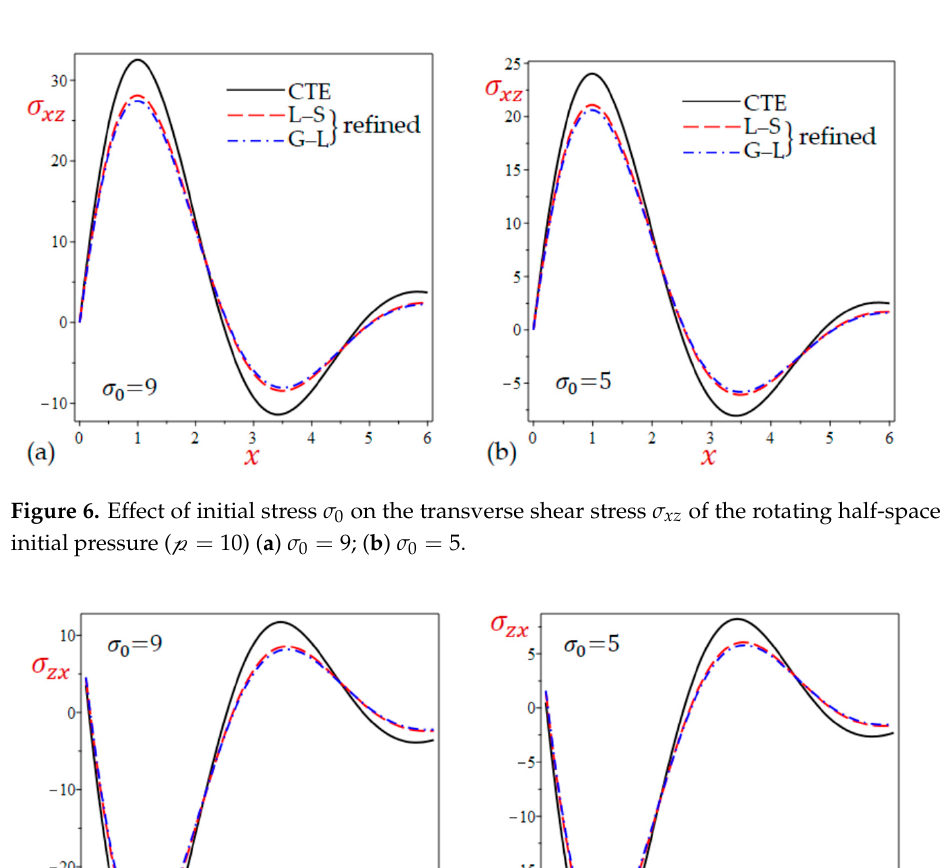
with initial pressure ( 𝓅 = 10 ) ( a ) 𝜎 (cid:2868) = 9 ; ( b ) 𝜎 (cid:2868) = 5 .